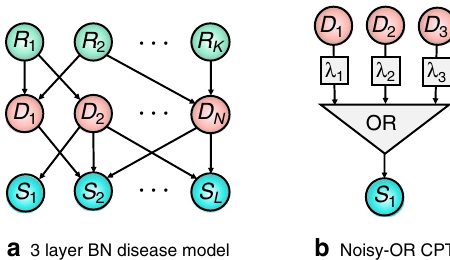
Fig. 2 Generative structure of our diagnostic Bayesian networks. a Three- layer Bayesian network representing risk factors R i , diseases D j and symptoms S k . b noisy-OR CPT. S is the Boolean OR function of its parents, each with an independent probability λ i of being ignored, removing them from the OR